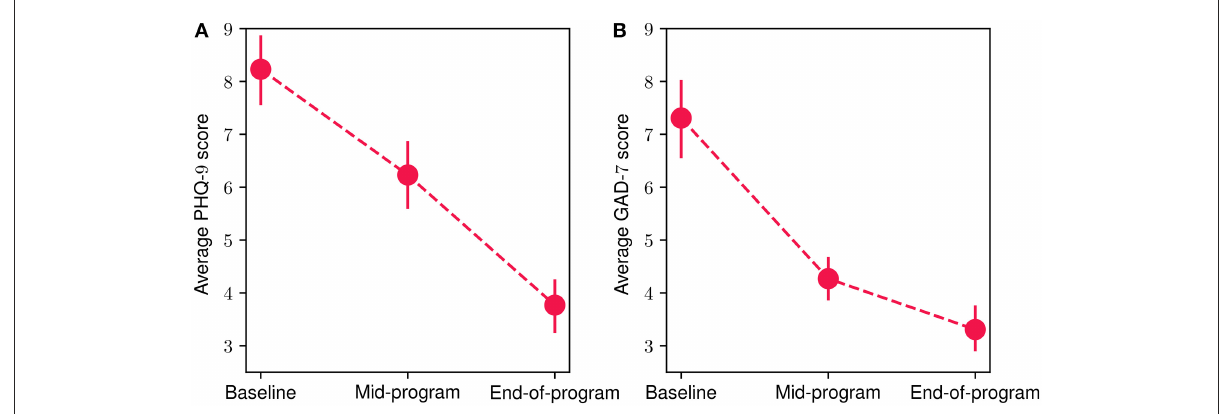
FIGURE7 Mean participant PHQ- 9 (A) and GAD- 7 (B) scores at baseline, mid-program and end-of-program evaluations. The vertical bars represent the standard error.